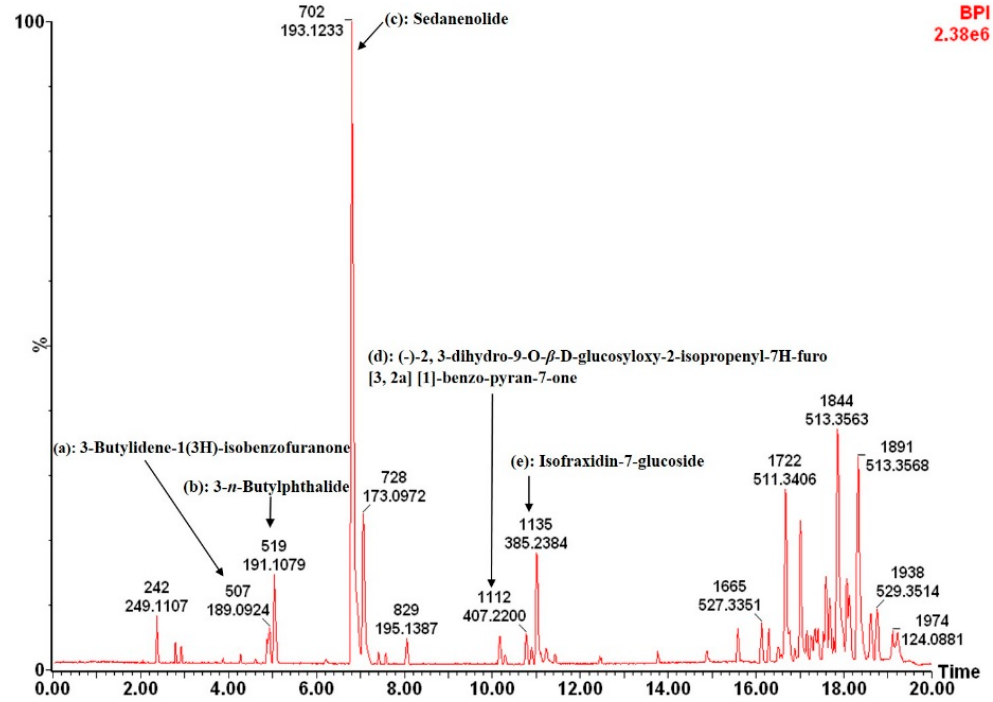
Figure 2. Ultra performance liquid chromatography-mass spectrometry (UHPLC-MS) chromatogram of the ethyl acetate crude extract of Apium graveolens indicating the presence of compounds identified using mass spectral data corresponding to positive